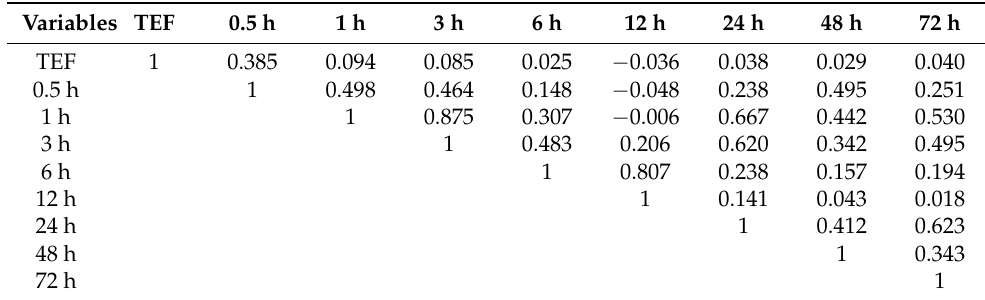
Table 5. Correlation matrix of